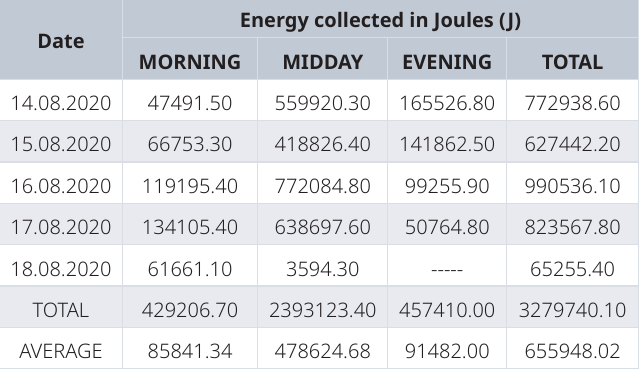
Table 1. Energy collected by stationary solar